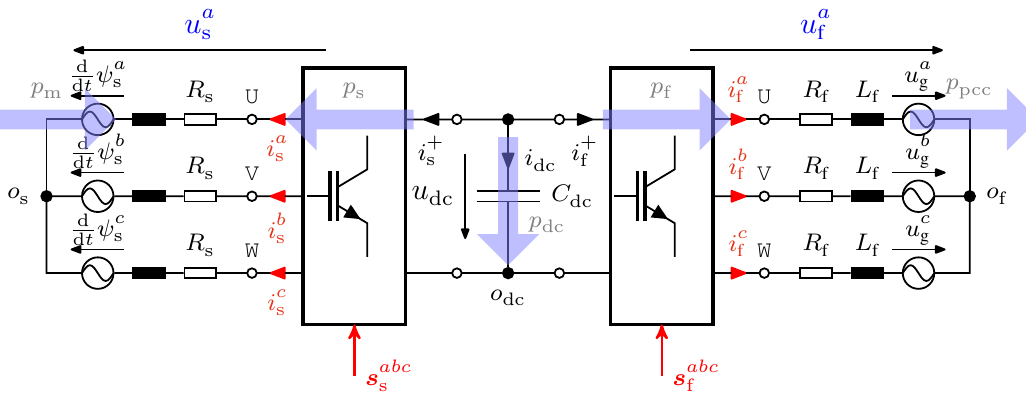
Figure 5. Electrical network of overall WTS: PMSG ( left ), back-to-back converter ( middle ) sharing a common DC-link, grid-side filter, point of common coupling (PCC) and balanced grid ( right , neglecting the